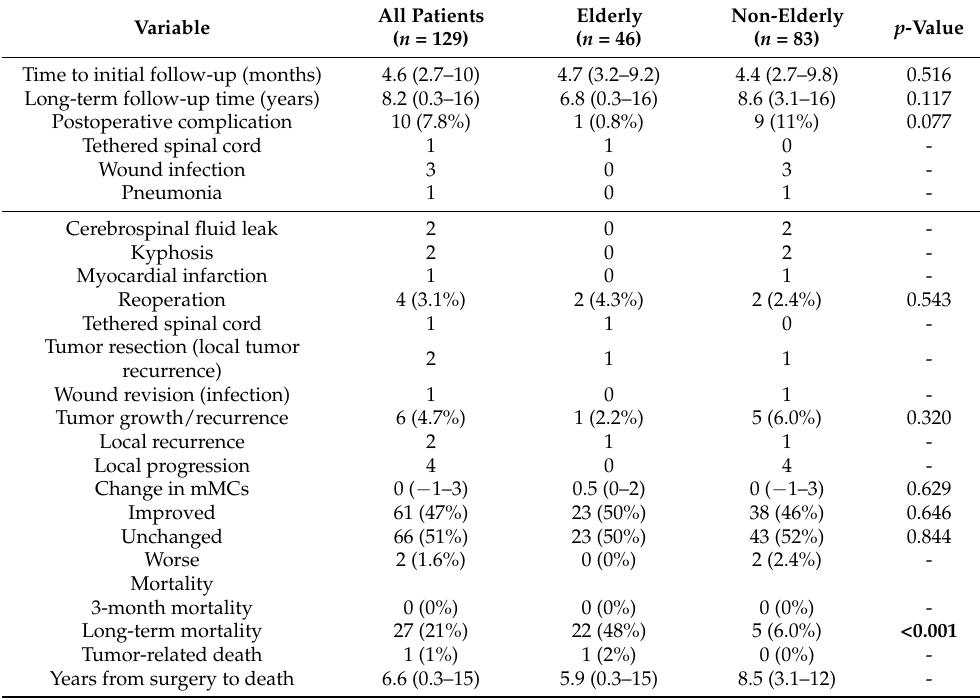
Table 4. Outcome